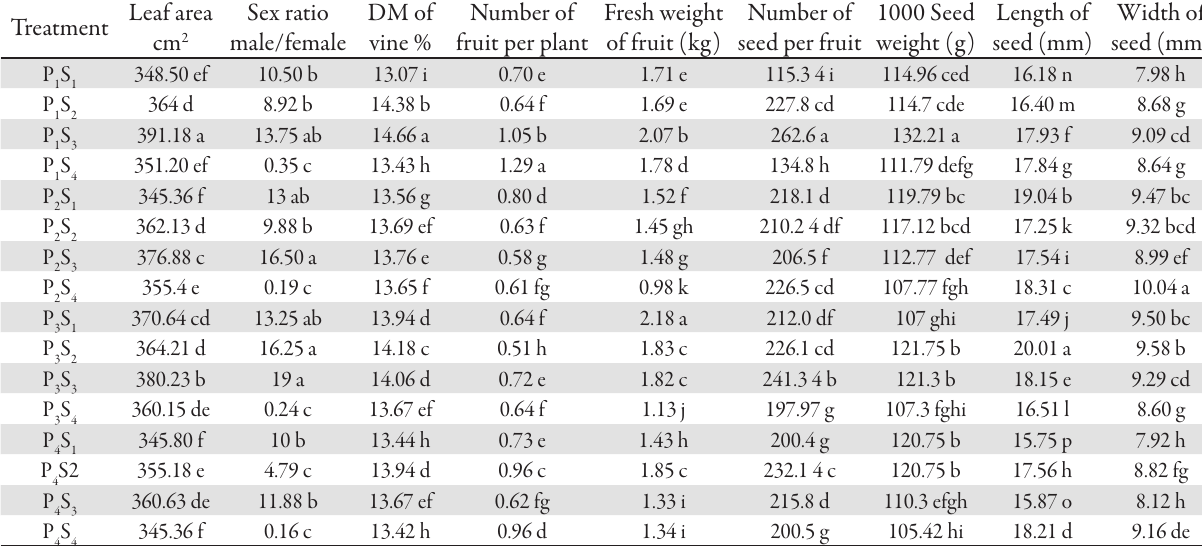
Tab. 3. Effect of PGRs on growth and yield characteristics of ( Cucurbita pepo var . styriaca cv. ‘Kaki’) in trellis method Leaf area Treatment cm 2